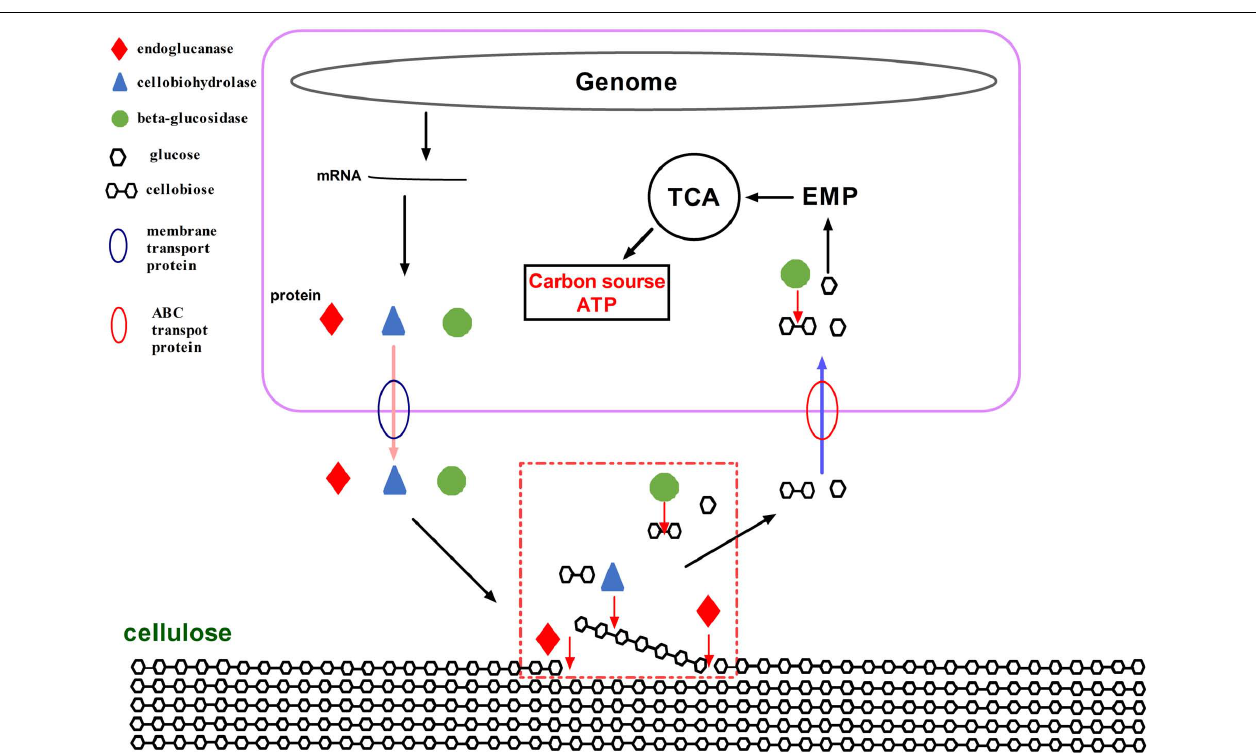
FIGURE 8 | Schematic diagram of hydrolytic cellulose from A. amylolytica YIM 77502 T